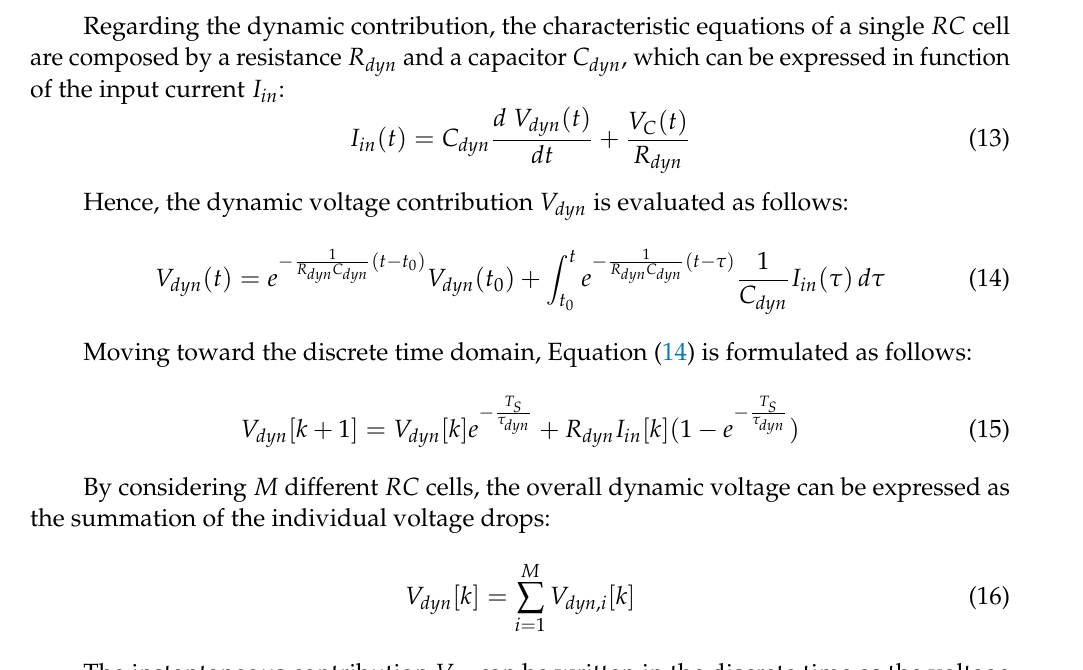
Figure 5. Voltage response of the A123 Nanophosphate AHR23113M1Ultra-B cell to the current profile used for the system identification procedure